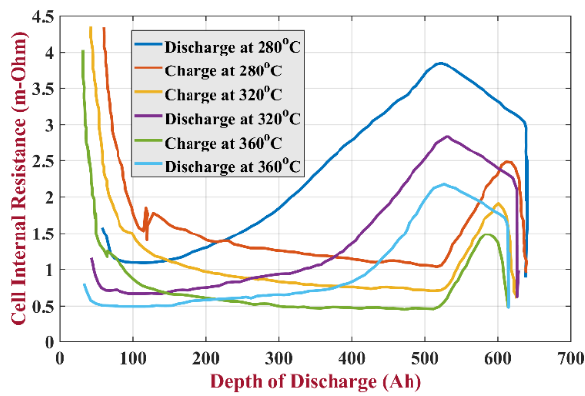
Figure 31. Schematic diagram of NaS battery: Molten S is used in the positive electrode and molten Na is used in the negative electrode; solid beta alumina ceramic is the electrolyte and separator [75].